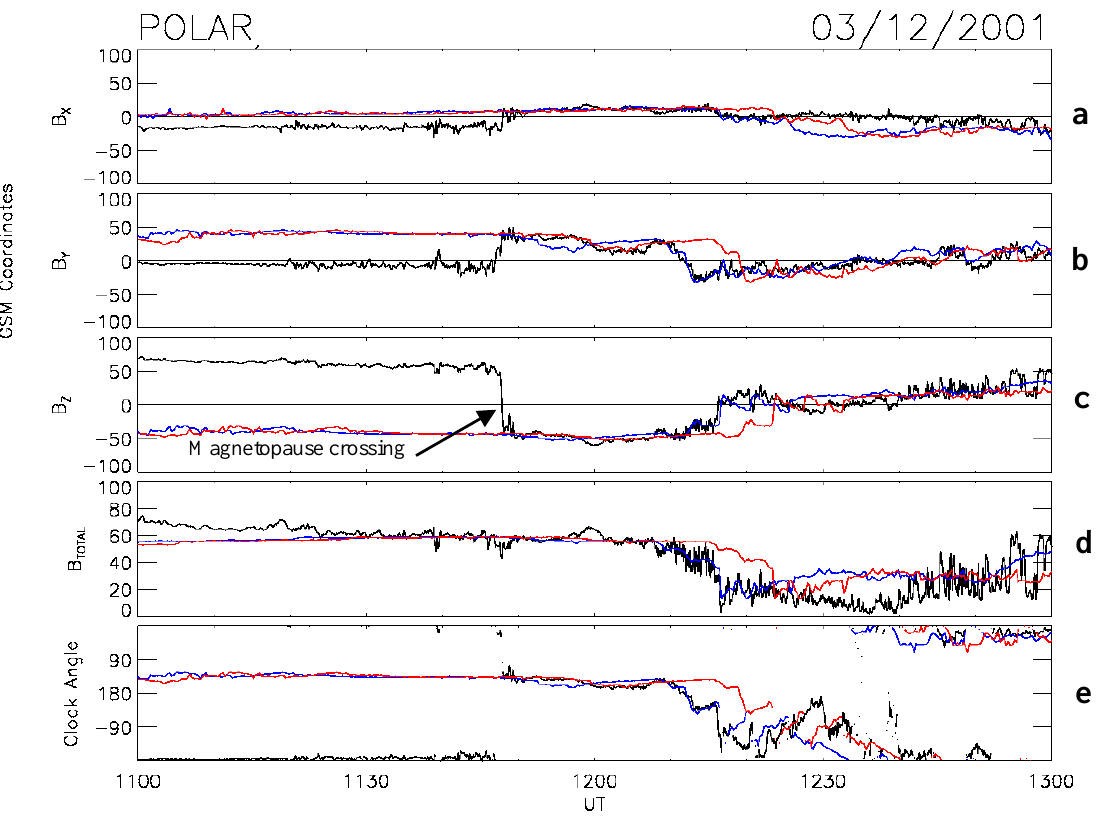
Fig. 5. Comparisons of the components, magnitude and clock angle of the magnetic fields measured at ACE (red and blue) and at Polar (black). The lag time is set at 70.5min for the red ACE traces, which is appropriate for the magnetopause crossing observed at 11:48UT and the next 15min. A lag time of 63.5min (blue ACE traces) was used to bring into alignment the region around the directional discontinuities. The scale for ACE data is one-sixth of that